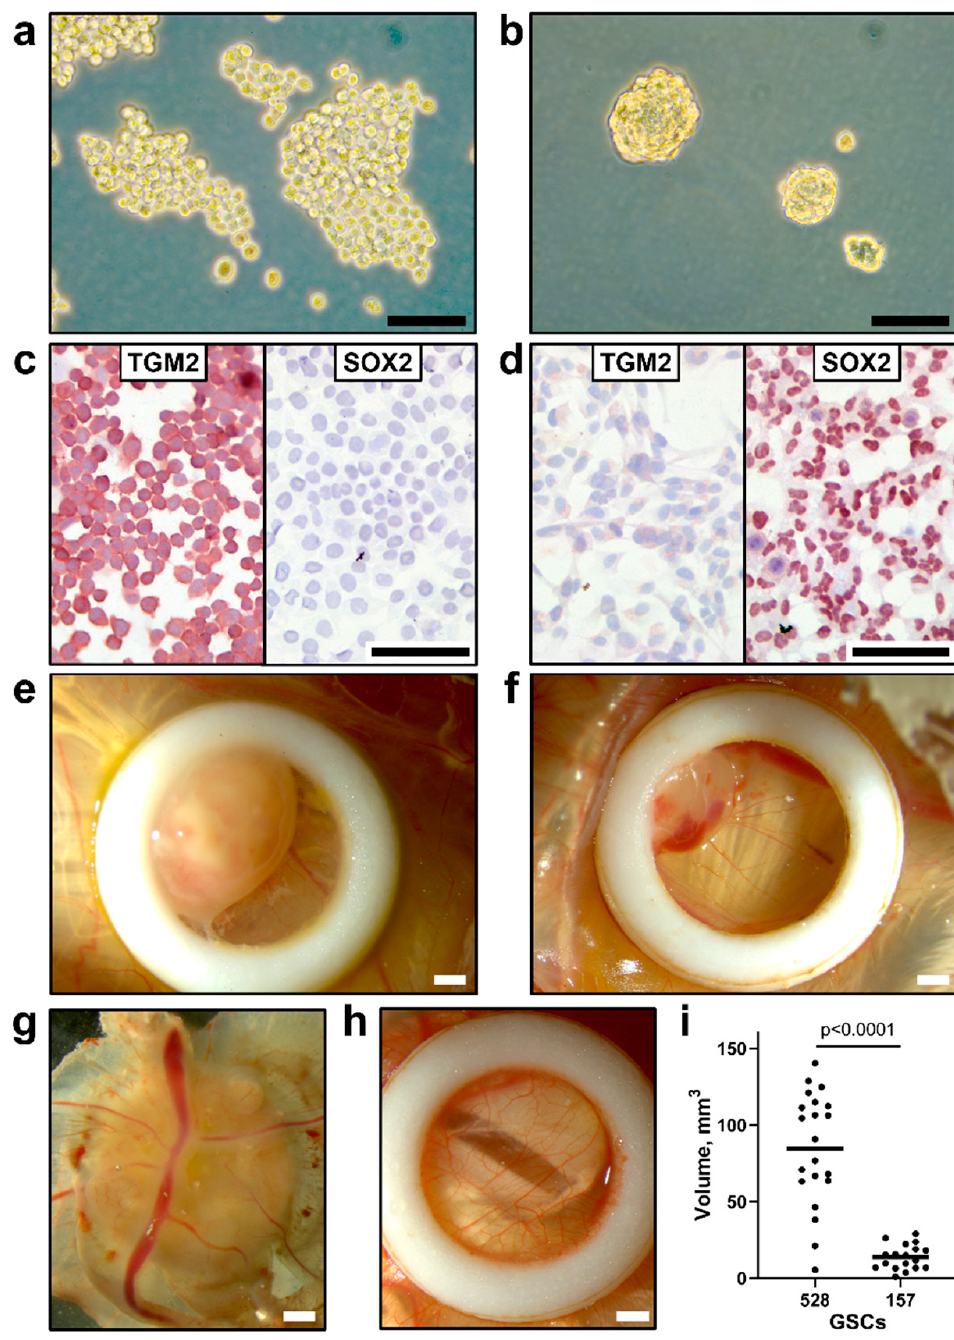
Figure 3. Morphology of glioblastoma stem cells ( a : GSC 528; b : GSC 157) in vitro; phase-contrast microscopy. ( c ) Positive TGM2 and negative SOX2 staining in GSC 528. ( d ) Negative TGM2 and positive SOX2 staining in GSC 157. Morphology of GSC tumors ( e: GSC 528; f : GSC 157) in in ovo cultures by bright-field microscopy. ( g ) Vascularization of a GSC tumor. ( h ) Intact chorioallantoic membrane in a control egg. ( i ) The volume of tumors formed at sampling (day 19 of embryonic development (ED); Mann–Whitney test). Scale bars are 0.1 ( a – d ) and 1 mm ( e – h ). Implantation efficiency of GSC cell cultures (GSC 528: n = 27, GSC 157: n = 26) on chicken embryo CAM (GSC 528: 96%, GSC 157: 88%) and egg viability at ED 19 (GSC 528: 92%, GSC 157: 93%) were comparable in both GSC models.